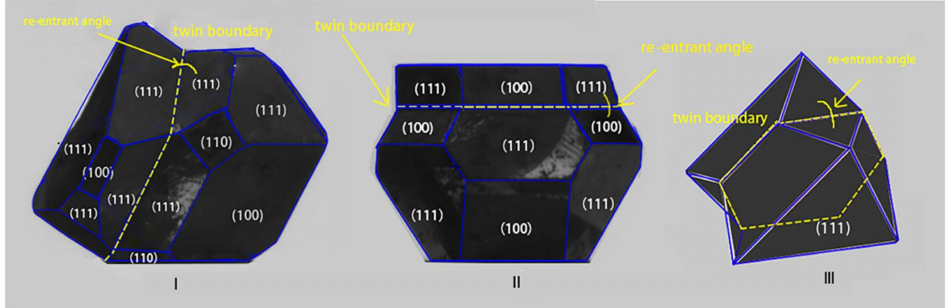
Figure 7. The type of contact twinning in HPHT synthetically grown diamond: ( I ) the number and development of {100} and {111} growth sectors on either side of the twin boundary were different in type I; ( II ) the single crystal of the twining contacts the planes of (100) and (111) in type II; ( III ) the crystal morphology seems similar to the Macle in natural diamonds in type